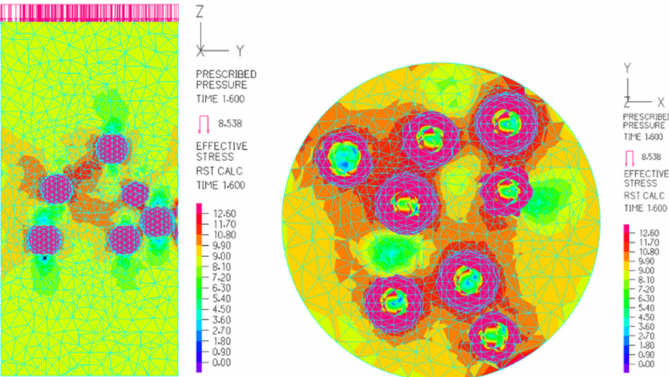
Figure 14. The internal stress diagram of SB concrete (SB30–56).